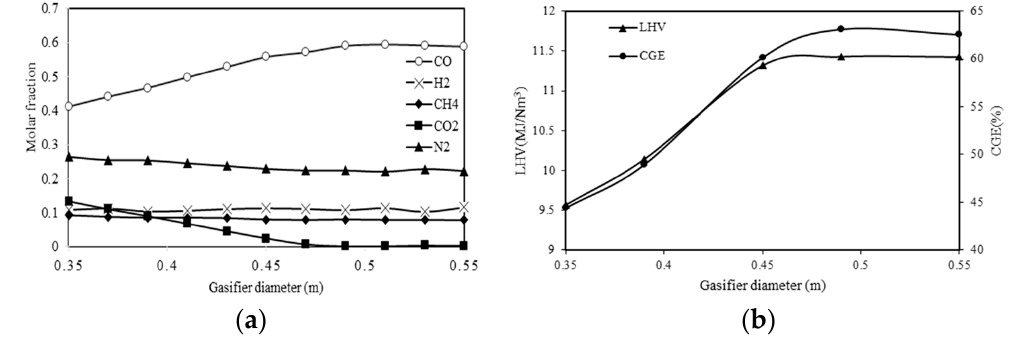
Figure 5. Effect of the gasifier diameter on: a) the gas composition, b) the LHV and CGE. Figure 5. E ff ect of the gasifier diameter on: ( a ) the gas composition, ( b ) the LHV and